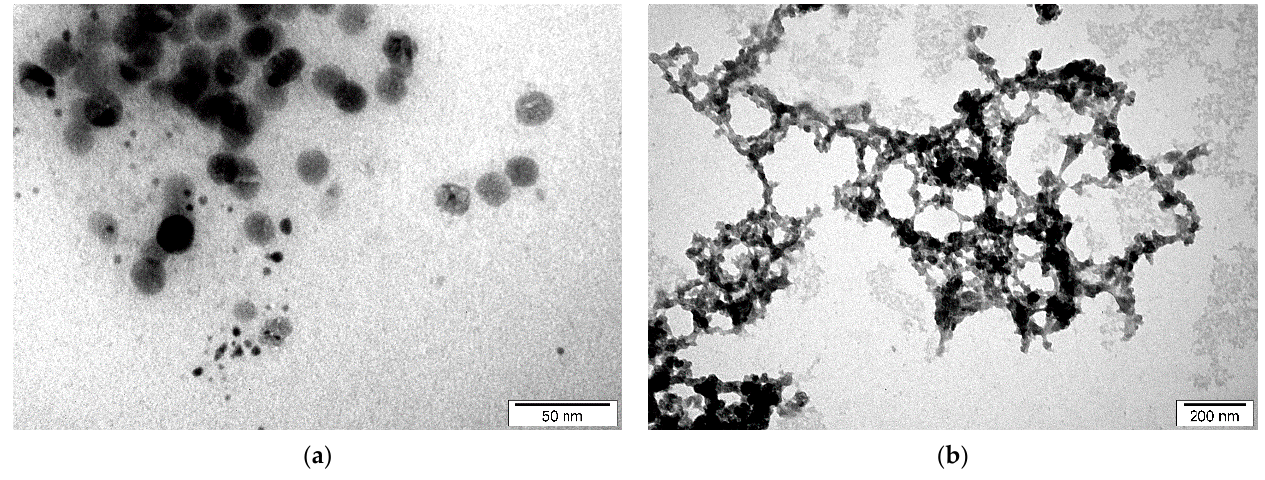
Figure 4. TEM micrographs of Samples ( a ) B_W1 and ( b ) C_W1W2.